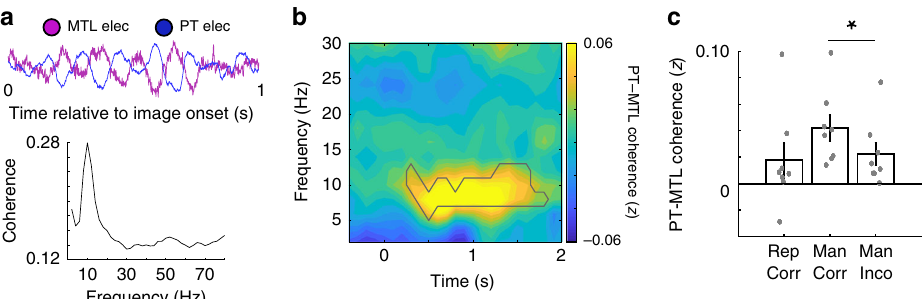
Fig. 6 Alpha coherence increases between MTL and PT when recognizing manipulated images. a Representative iEEG traces from a PT and MTL electrode in an example participant indicating low frequency coherence at the single trial level. Across all trials in this electrode pair, coherence spectrum showed a peak in the low frequency band. b Average coherence spectrum for all PT-MTL electrode pairs across participants (black outline, p < 0.05, permutation procedure). c Average low frequency coherence between PT and MTL electrodes across eight participants for manipulated correct, repeated correct, and manipulated incorrect conditions. Greater alpha coherence for the manipulated correct condition compared to the manipulated incorrect condition was observed ( t (7) = 2.54, p = 0.038, unpaired, two-tailed t test). All error bars indicate standard error of